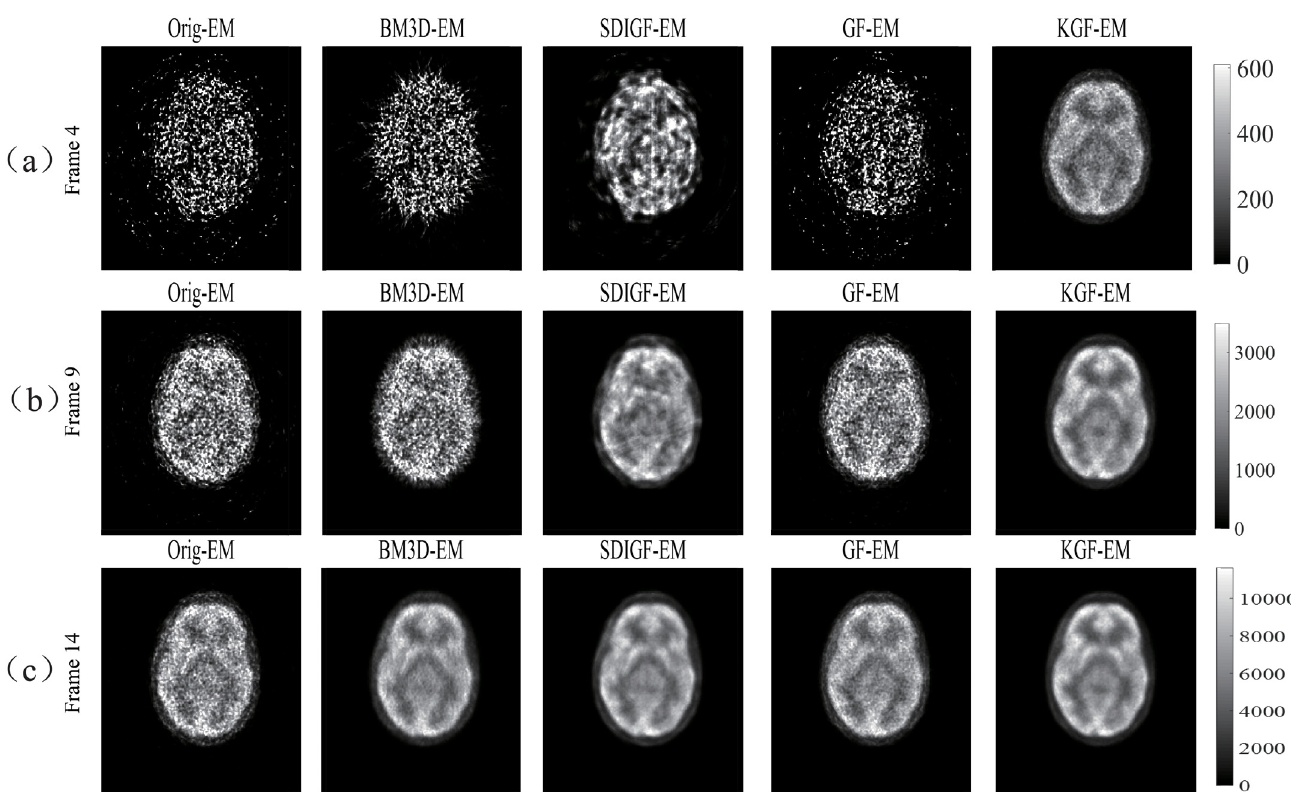
Fig 12. MLEM reconstructed images from the in-vivo sinogram datasets shown in Fig 11. Column Orig: original dataset, other columns: datasets denoised by respective methods.